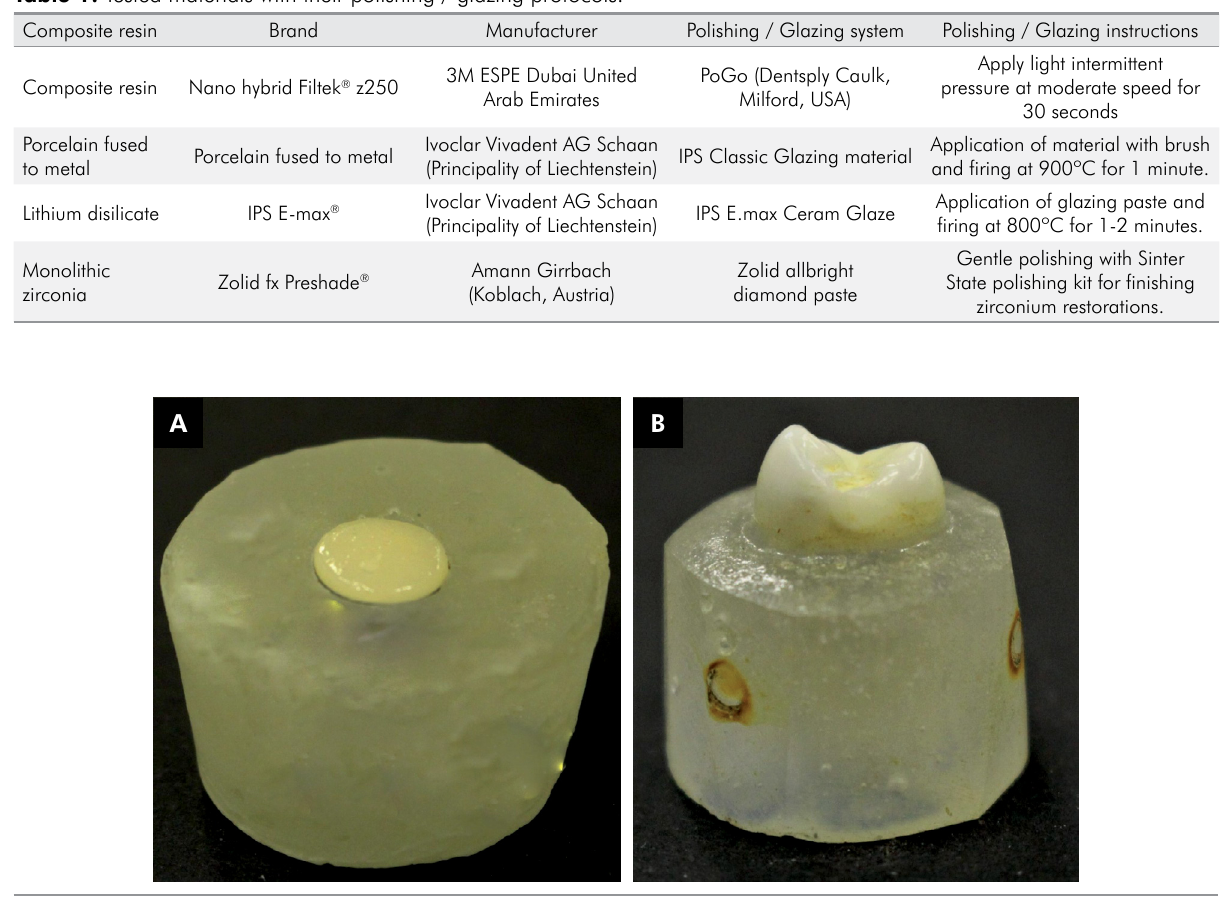
Figure 1. Material specimen embedded in a resin block (A); Tooth specimen embedded in a resin block (B).